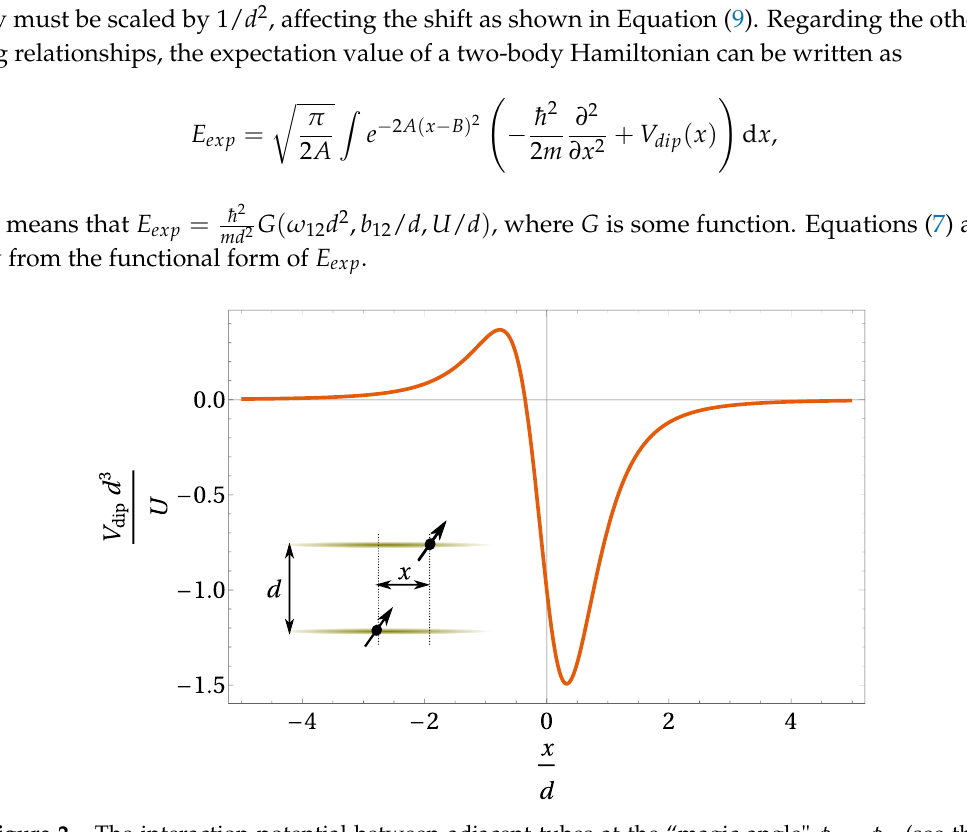
Figure 2. The interaction potential between adjacent tubes at the “magic angle" φ = φ m (see the text for the definition of the angle). The potential is given by Equation (3) with n = 1 and φ = φ m